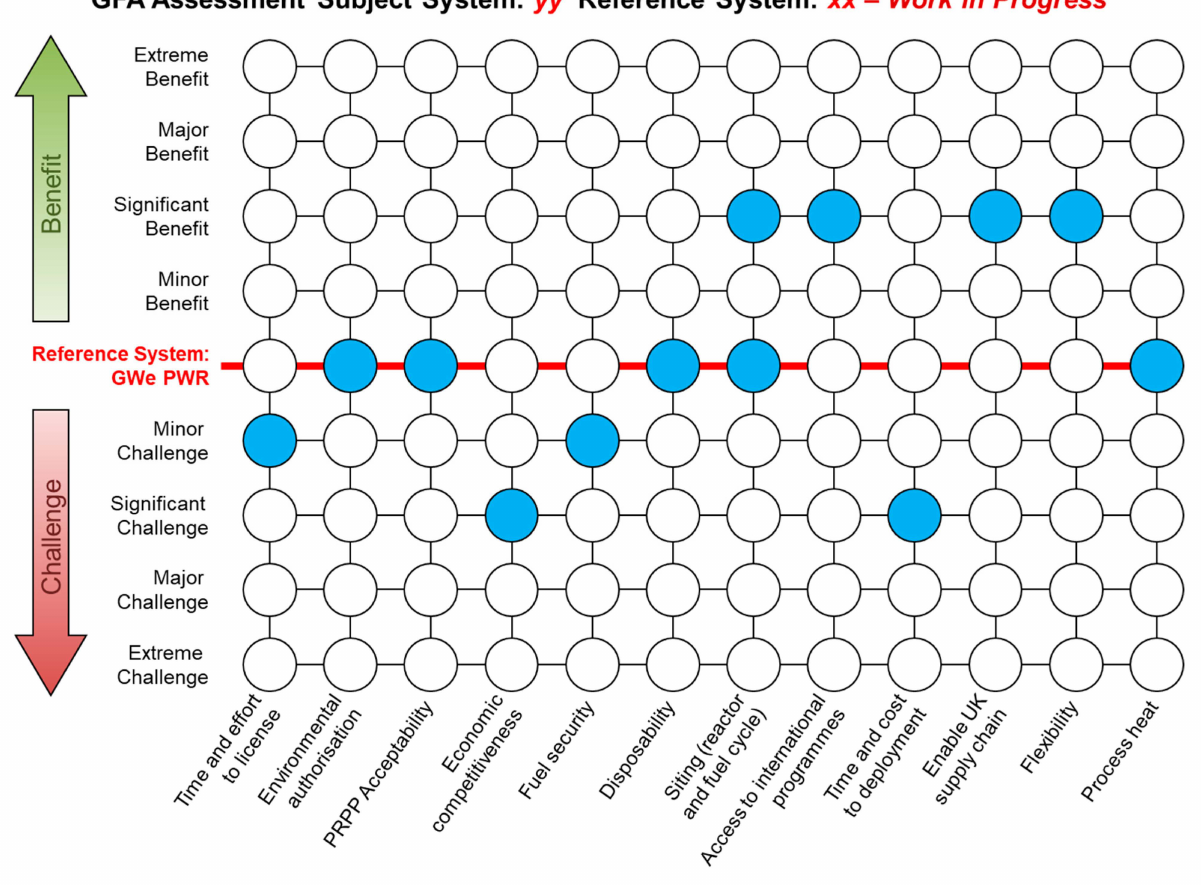
Figure 5. GFA Assessment Template Version 14,